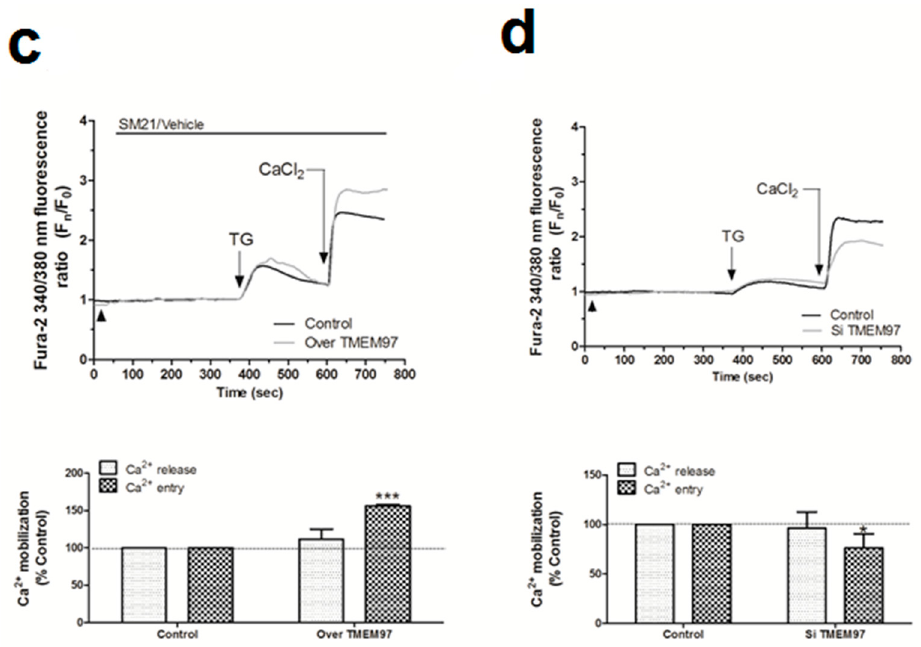
Figure 6. σ R/TMEM97 is involved in the changes of Ca 2+ homeostasis in MDA-MB-231 cells. MDA-MB-231 cells were allowed to grow on coverslips, and were loaded with fura-2/AM. They were subsequently maintained in an extracellular Ca 2+ -free HBS medium (containing 75 μ M of Ethylene Glycol Tetraacetic Acid (EGTA), arrowheads) and incubated with NO1 (100 nM, ( a )) or SM21 (100 nM, ( b )) or the vehicle, before stimulating store-operated calcium entry (SOCE) by adding thapsigargin (TG) (2 μ M, ( a )). Alternatively, cells were supplemented with NO1 after the stimulation of SOCE with TG ( b ). Furthermore, MDA-MB-231 cells were genetically modified by overexpressing or silencing σ R/TMEM97 (( c , d ), respectively), as described in the Material and Methods section. Cells were then loaded with fura-2/AM, and SOCE was activated by incubating with TG (2 μ M) for 4 min. TG-evoked SOCE was monitored in all cases by supplementing the extracellular medium with 1 mM of CaCl 2 . Changes of SOCE, evoked by incubating either with the σ R/TMEM97 ligands or by genetic cell modification, were analyzed by determining the areas under the curves for 2 min after the addition of CaCl 2 . Graphs are representative of 6–8 independent experiments, and histograms represent the average of the percentage ± standard error of the mean (S.E.M.) compared to cells nontreated with the σ 2R/TMEM97 ligands or nongenetically modified cells (control cells). * and ***, represent p < 0.05 and <0.001, respectively, with respect to the percentage found in control cells.